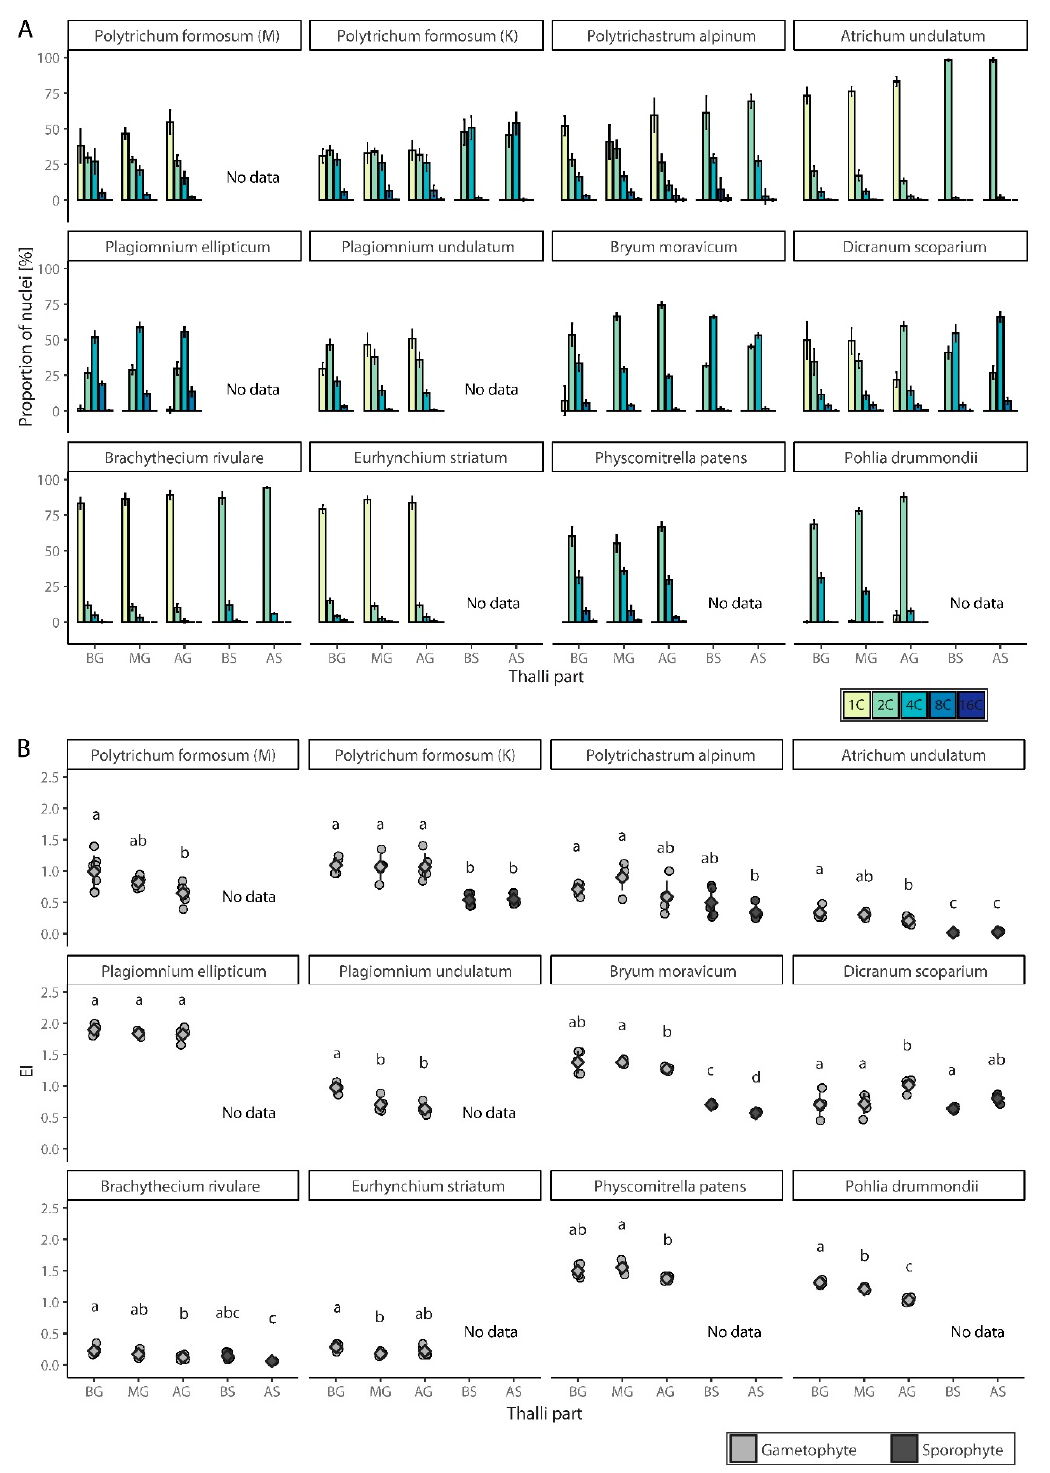
Figure 2. Endopolyploidy level in studied mosses. ( A ) Percentual distribution (mean ± SD) of different categories of nuclei. ( B ) Jitter plot with mean ± SD for endoreduplication index (EI) values. BG, basal part of gametophyte; MG, middle part of gametophyte; AG, apical part of gametophyte; BS, basal part of sporophyte; AS, apical part of sporophyte. Different populations of P. formosum are coded as M and K, reflecting name of collection site; M, Milpoš; K, Kamenica. Homogenic groups revealed by ANOVA (or Kruskal-Wallis test) and Tukey’s HSD test (or Mann-Whitney post hoc test) are denoted by lower case letters.